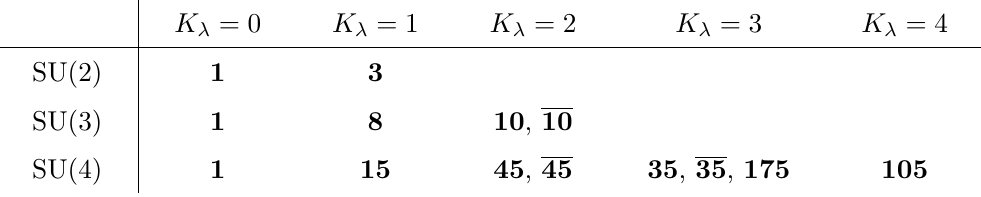
Table 4 . The SU( N ) representations of the Kac-Moody primaries for N = 2 , 3 , 4 and the corre- sponding values K = K λ where they